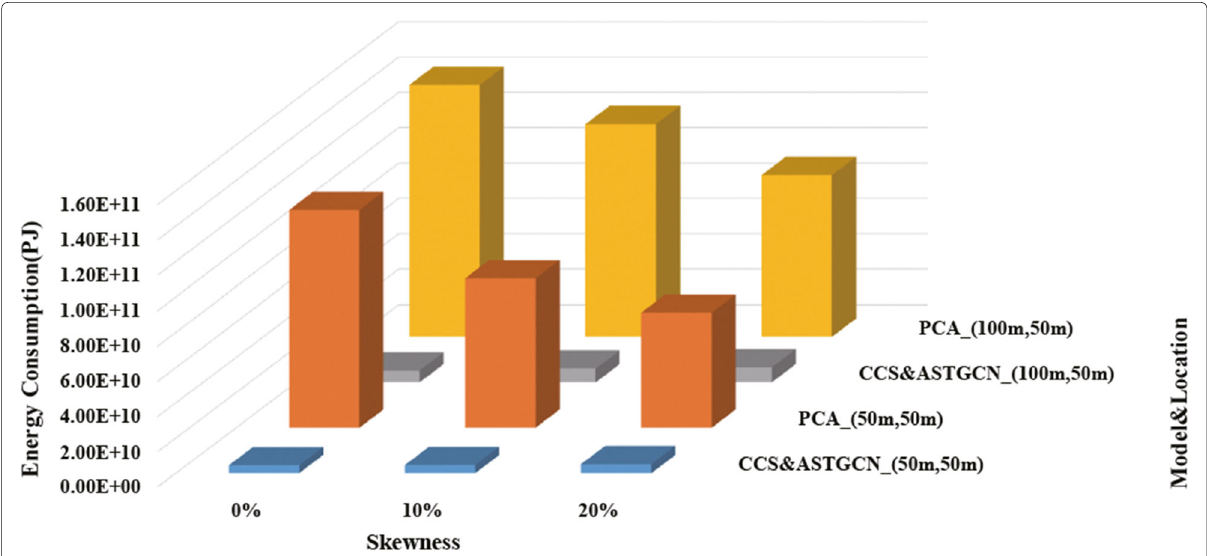
Fig. 9 Comparison of energy consumption of PCA and CCS&ASTGCN mechanism with various skewness of nodes distribution and locations of the